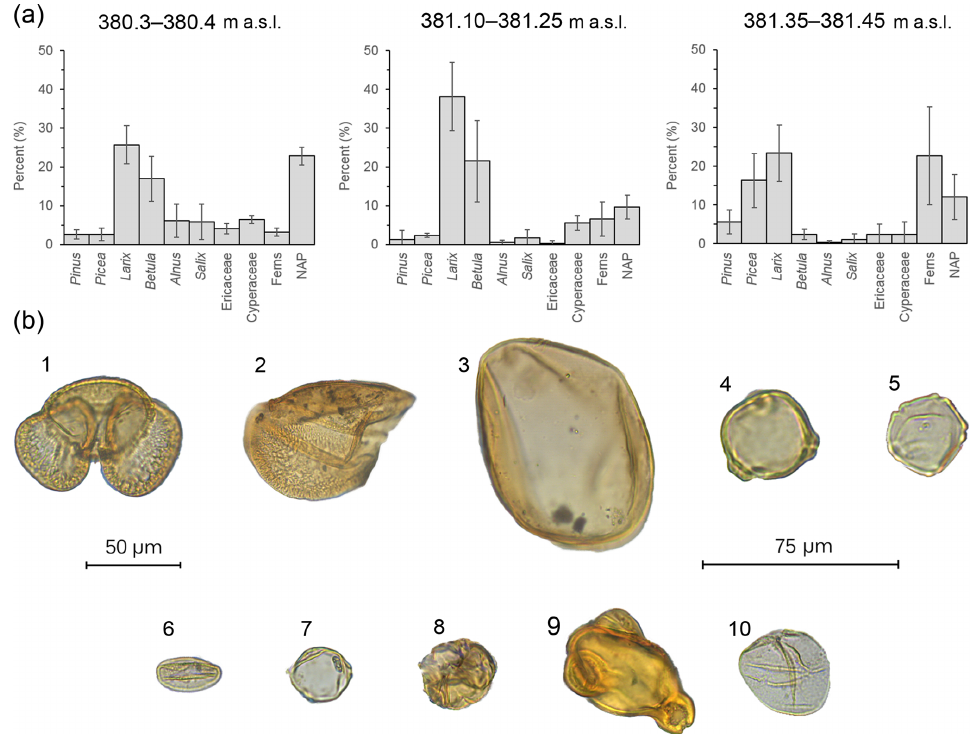
Figure 5. (a) Bar charts showing the relative pollen abundance in each portion of the section (error bars: 95% confidence intervals; ma.s.l. – meters above sea level). (b) Pollen plate of select grains encountered in the BP section: (1) Pinus , (2) half a Picea grain, (3) Larix , (4) Betula ,